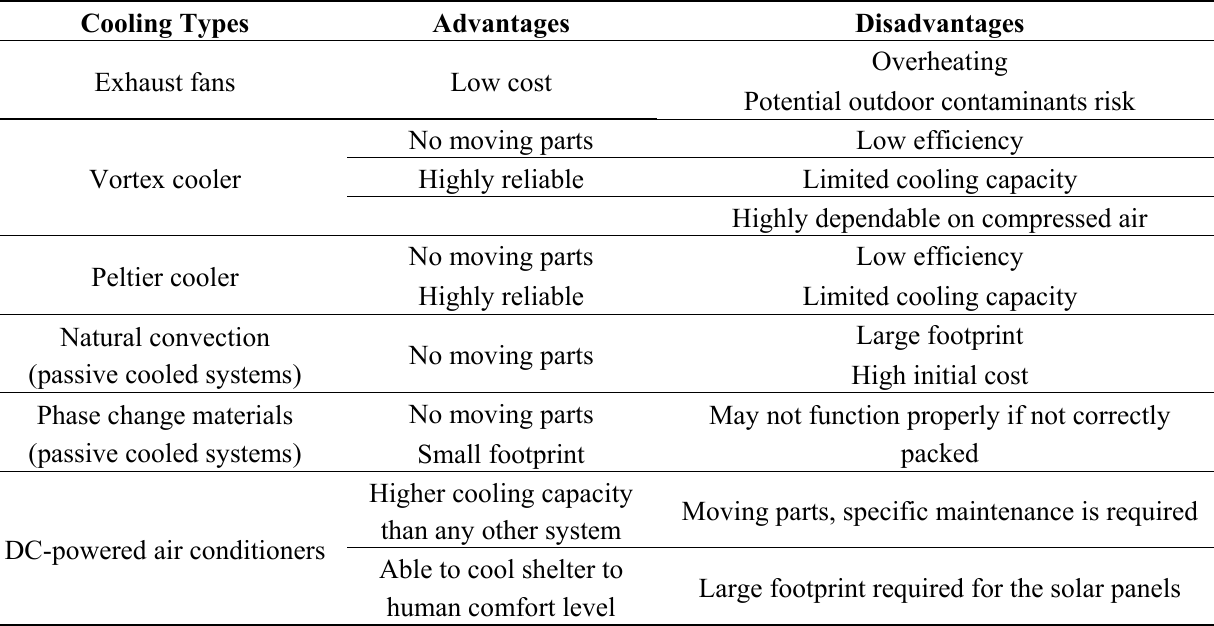
Table 1. Cooling types for off-grid base station